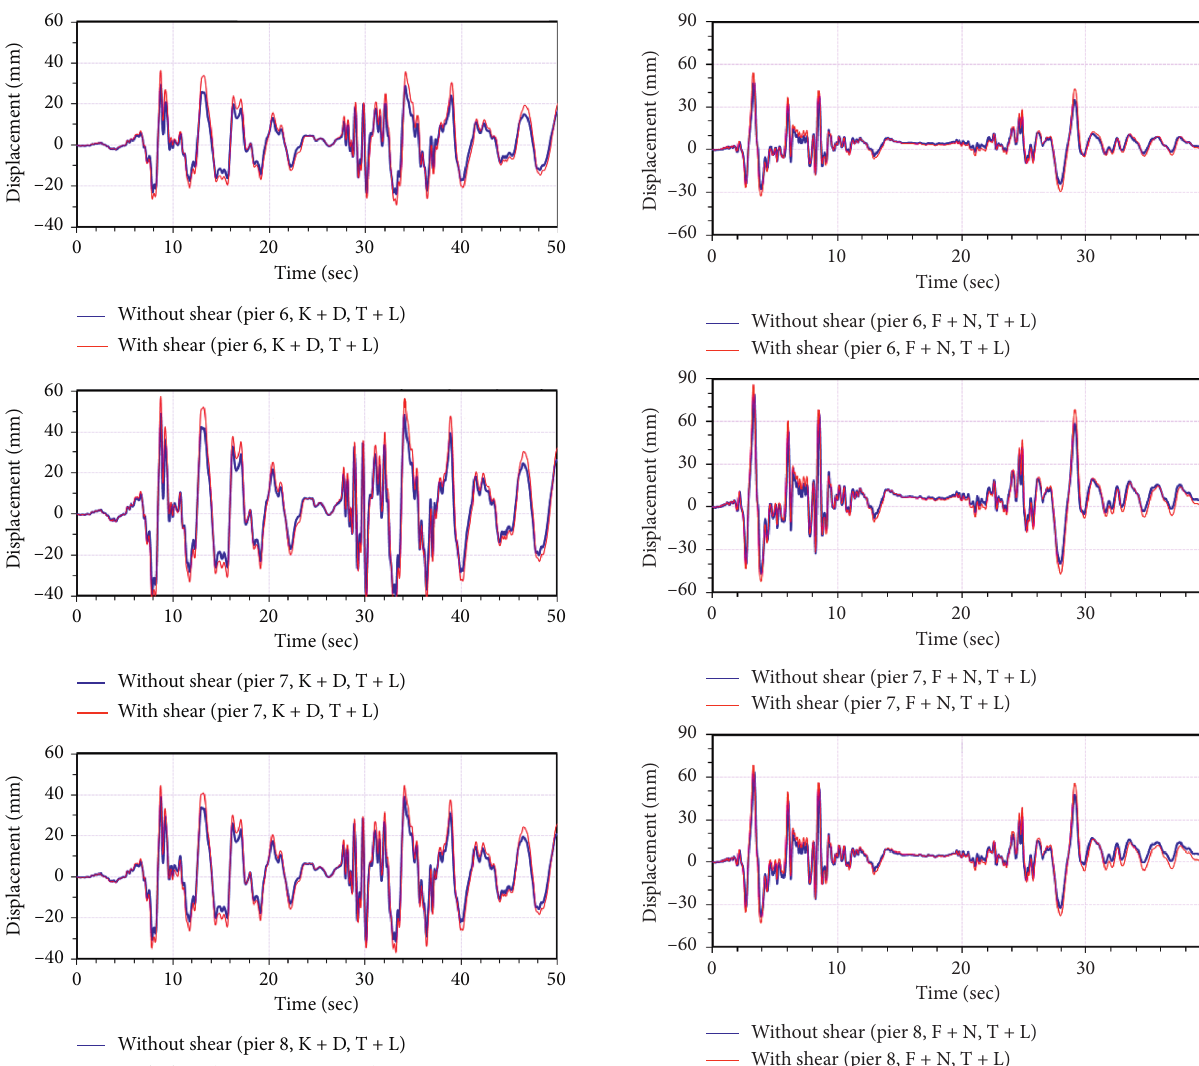
Figure 12: Transverse displacement response without and with shear subjected to biaxial input ground motions of multiple earthquakes,